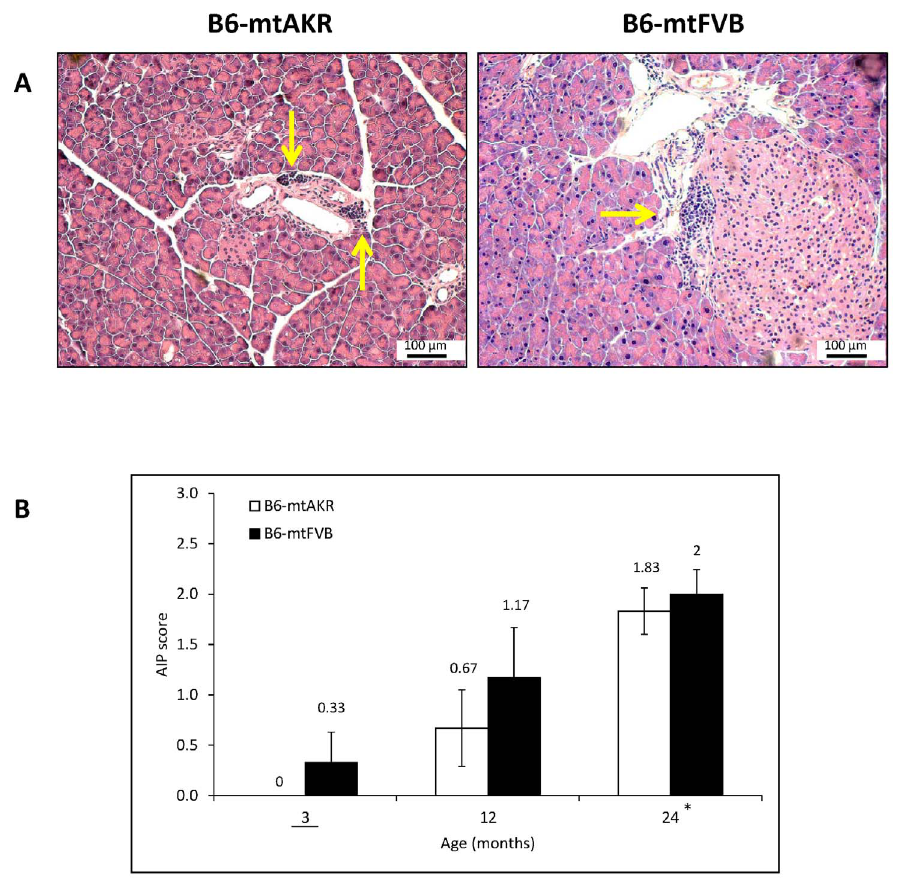
Figure 6. Foci of immune cells in B6-mtAKR and B6-mtFVB mice. Pancreatic sections of untreated 3, 12 and 24-month-old B6-mtAKR and B6- mtFVB mice were stained with H&E and analyzed regarding the presence of autoimmune-like pancreatic lesions. (A) The microphotographs show typical examples of immune cell infiltrates (indicated by arrows) with periductal, perivascular and periinsular location in 12-month-old B6-mtAKR (left) and B6-mtFVB (right) mice. (B) The samples were further evaluated by using a scoring system from 0 to 4. The data are indicated as mean 6 SEM for n=5–12 mice per experimental group. *P U , 0.001 vs. 0 h (Bonferroni-adjusted a =0.0166).